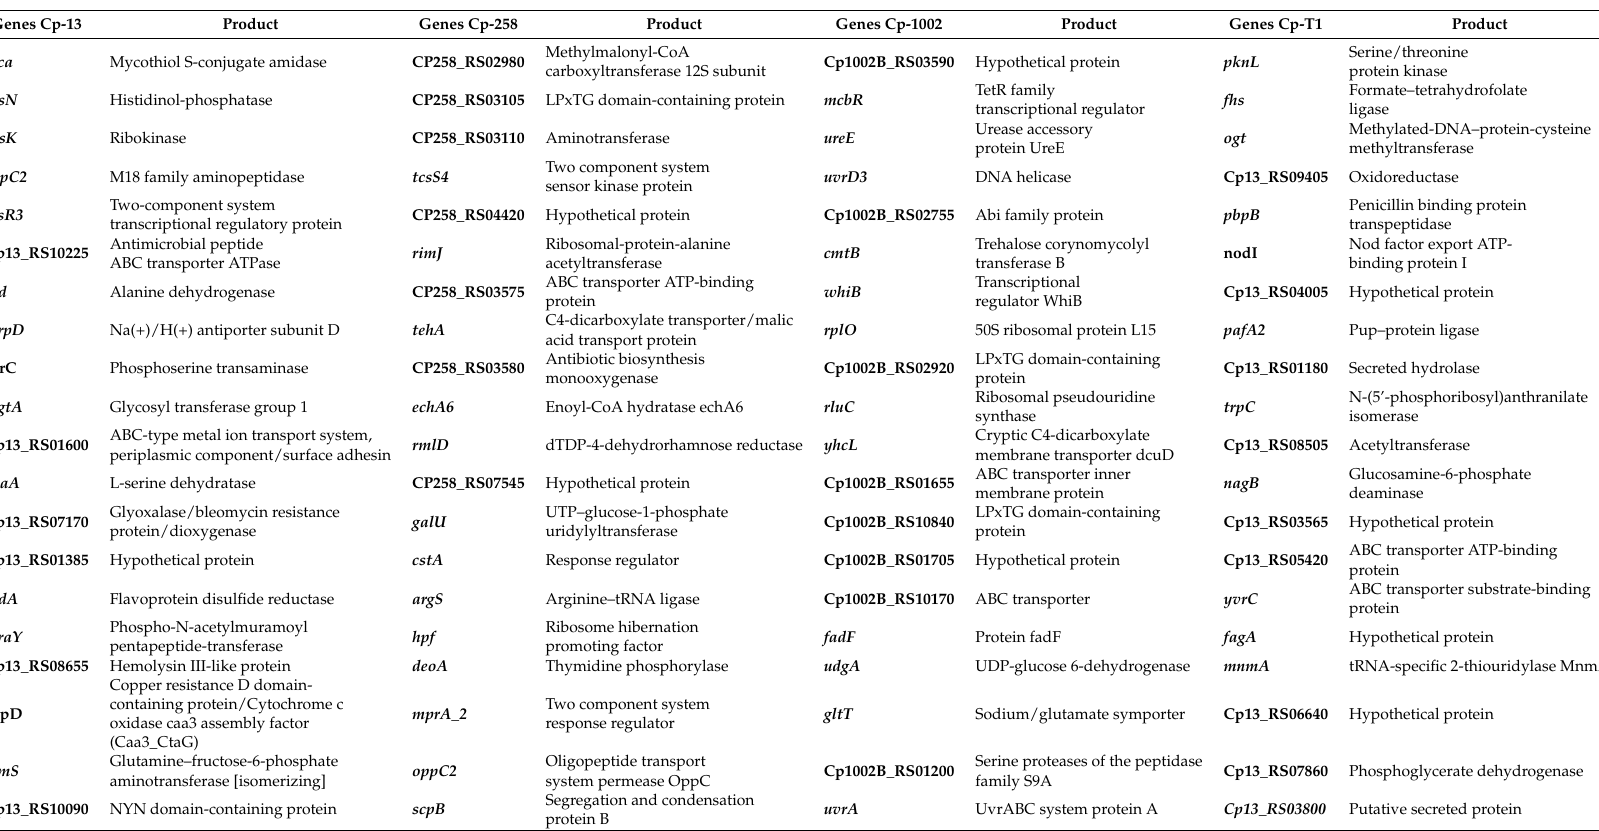
Table 4. Products generated by the top 20 influential genes identified in the networks built with the whole genome expression data from Cp-13, Cp-258, and